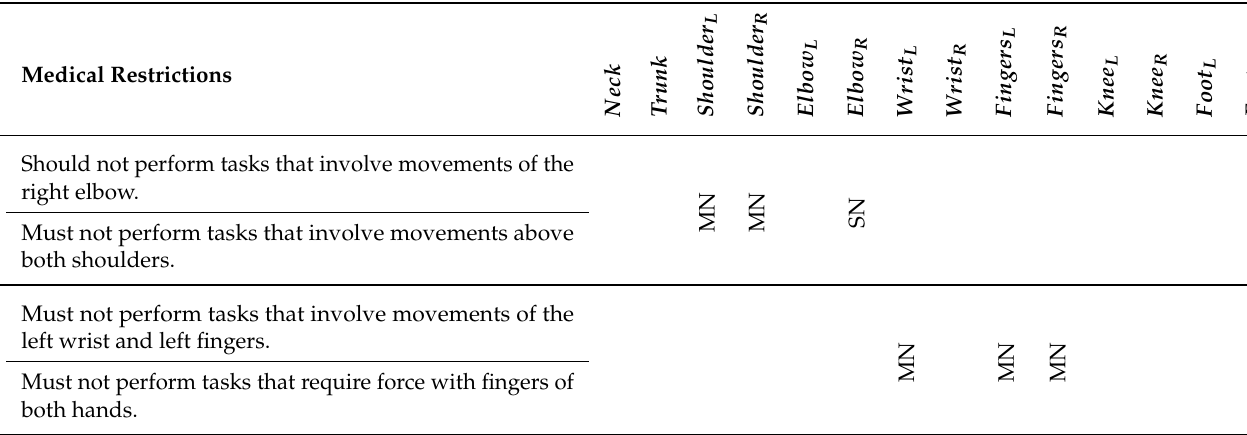
Table 1. Two rows of final tabular structured data.